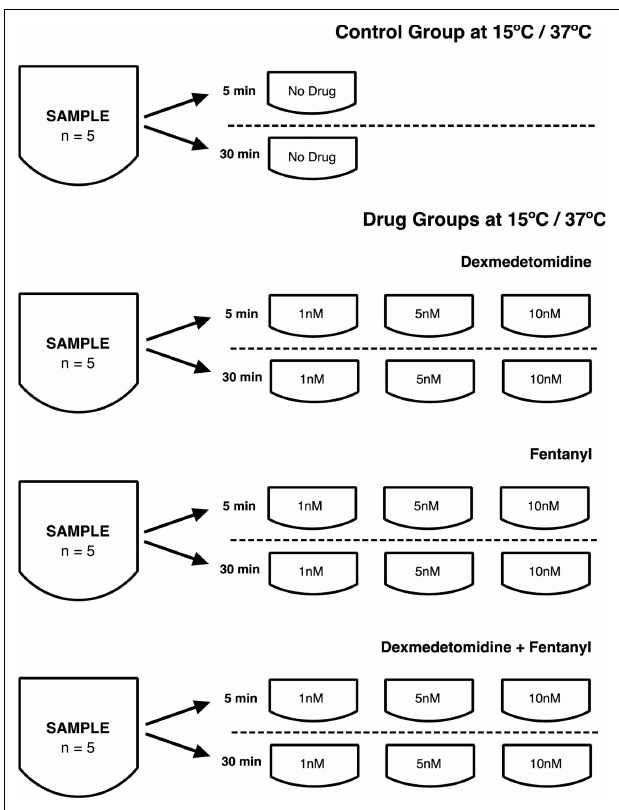
FIGURE 1 | Processing of human respiratory epithelia and preparation of cell groups